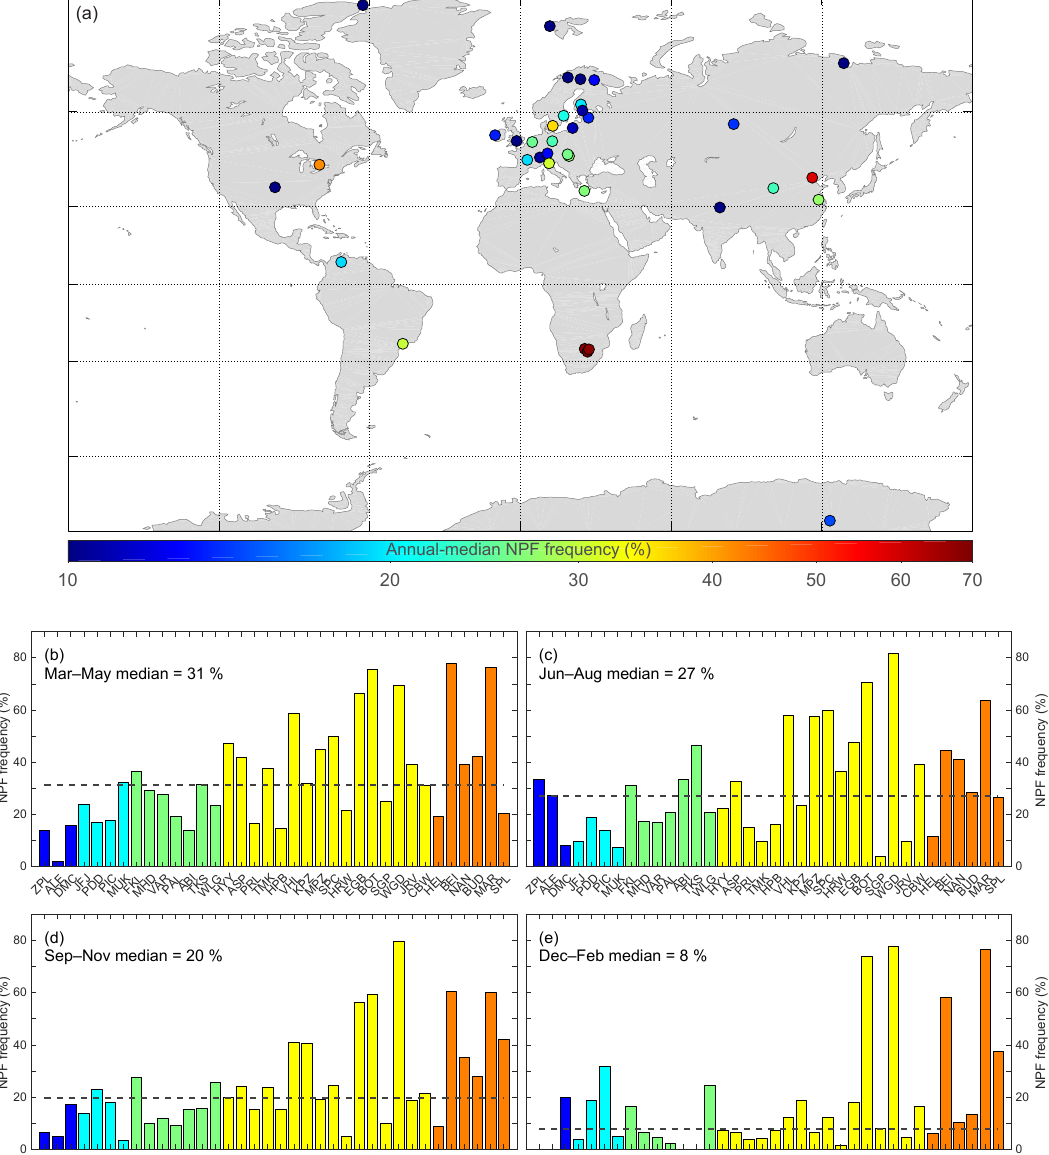
Figure 3. Annual-median (a) and seasonal-median (b–e) frequency of the NPF formation events at the different measurement sites. The dashed lines in panels (b–e) show the median seasonal values, and the color scheme represents the classification of the sites into polar, high-altitude, remote, rural, and urban